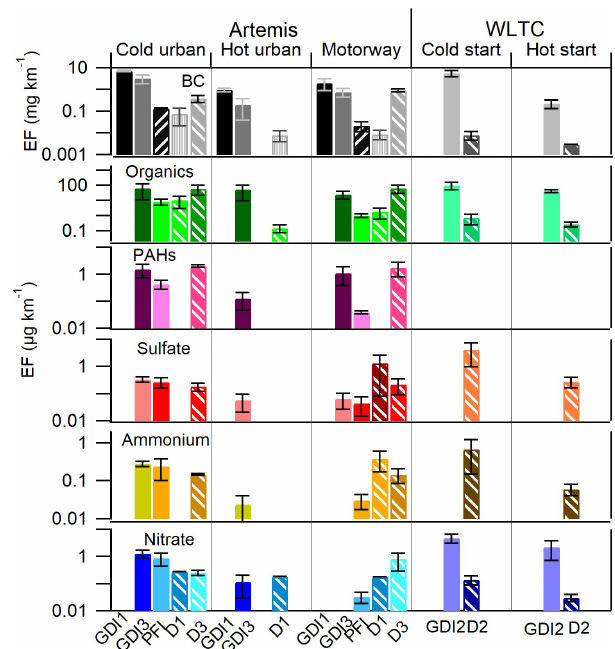
Figure 7. Emission factors for three diesel (D1, D2, and D3) and four gasoline (GDI1, GDI2, PFI, and GDI3) vehicles Euro 5: BC EFs are expressed in mgkm − 1 , while for organics, PAHs, sulfate, ammonium, and nitrate, the values are expressed in µgkm − 1 . Gaso- line vehicles are shown with solid bars and diesel vehicles with pat- tern bars. The error bars correspond to ± 1 σ standard